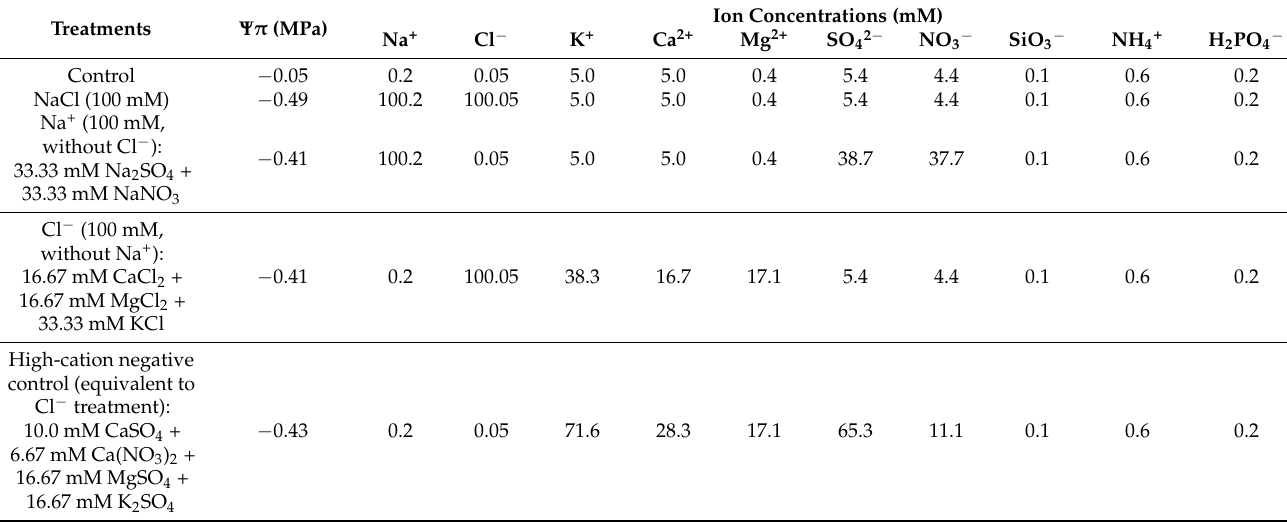
Table 1. Ion concentrations, salts used, and osmotic potential of the non-saline control and four salt treatments’ (100 mM Na + salts (without Cl − ), 100 mM Cl − salts (without Na + ), 100mM NaCl, and 100 mM high-cation negative control (no Na + , no Cl − )) nutrient